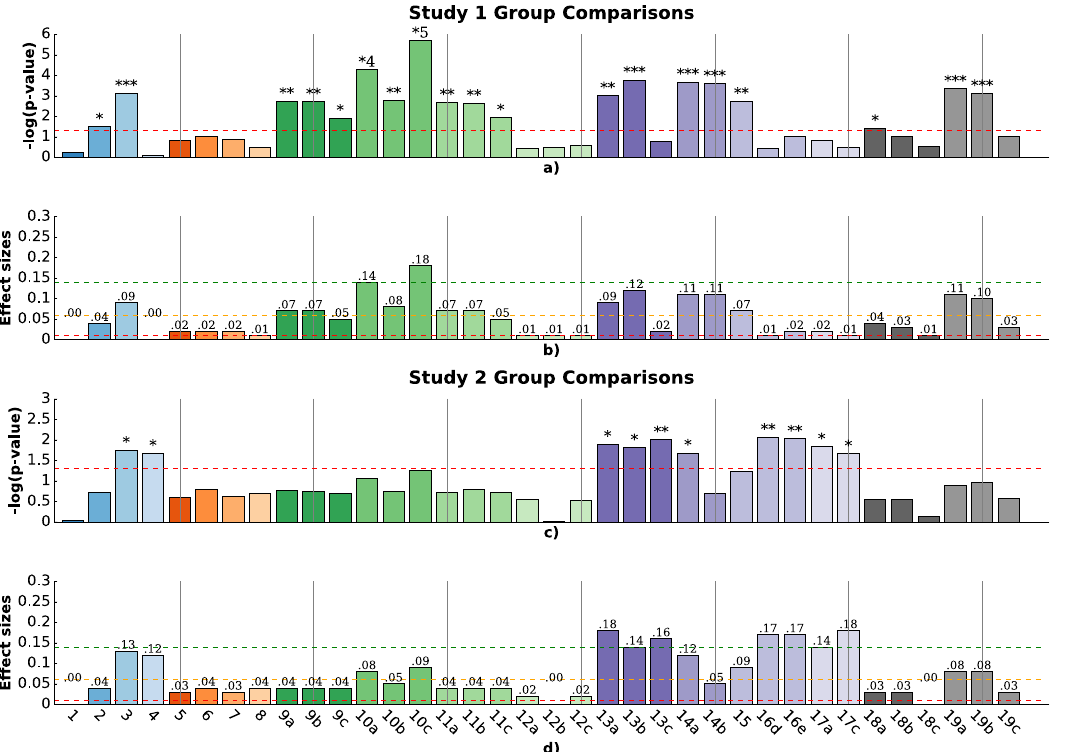
Fig. 1 P-values and associated effect sizes for group comparisons of the touch-related features for autistic versus neurotypical participants in study 1, and autistic participants with and without co-occurring ADHD in study 2. (1) number of touches ; (2) number of pops ; (3) bubble popping rate; (4) double touch rate ; (5) screen exploratory percentage ; (6) number of targeted ; (7) number of transitions ; (8) repeat percentage ; (9) touch duration ; (10) touch length of the touch motion ; (11) touch velocity ; (12) applied force ; (13) distance to the center ; (14) popping accuracy; (15) average variation of the popping accuracy; (16d) variability of the average popping accuracy ; (16e) variability of the maximum popping accuracy ; (17) number of touches per target ; (18) touch frequency ; (19) time spent on a targeted bubble . a Mean; b Median; c Standard deviation; * p < 0.05; ** p < 0.01; *** p < 0.001; *4: p < 0.00001; *5: p < 0.000001. P -values were computed using a one-way ANCOVA. Red dotted line indicates statistical signi fi cance at level 5%. P -values were corrected using Benjamini – Hochberg procedure to control for FDR. Red, orange, and green dotted lines indicate standard levels associated with a low ( η 2 = .01), middle ( η 2 = .04), and large ( η 2 = .14) effect